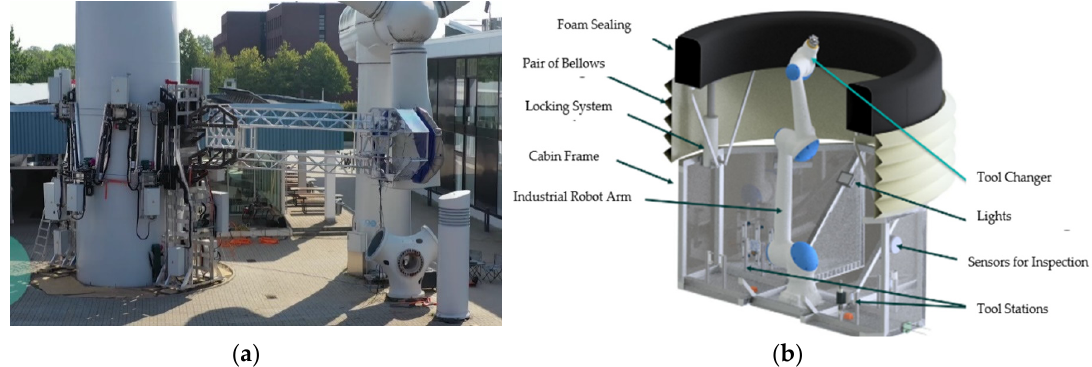
Figure 13. CRR prototype. ( a ) Test site in Cologne, Germany; ( b ) Maintenance cabin